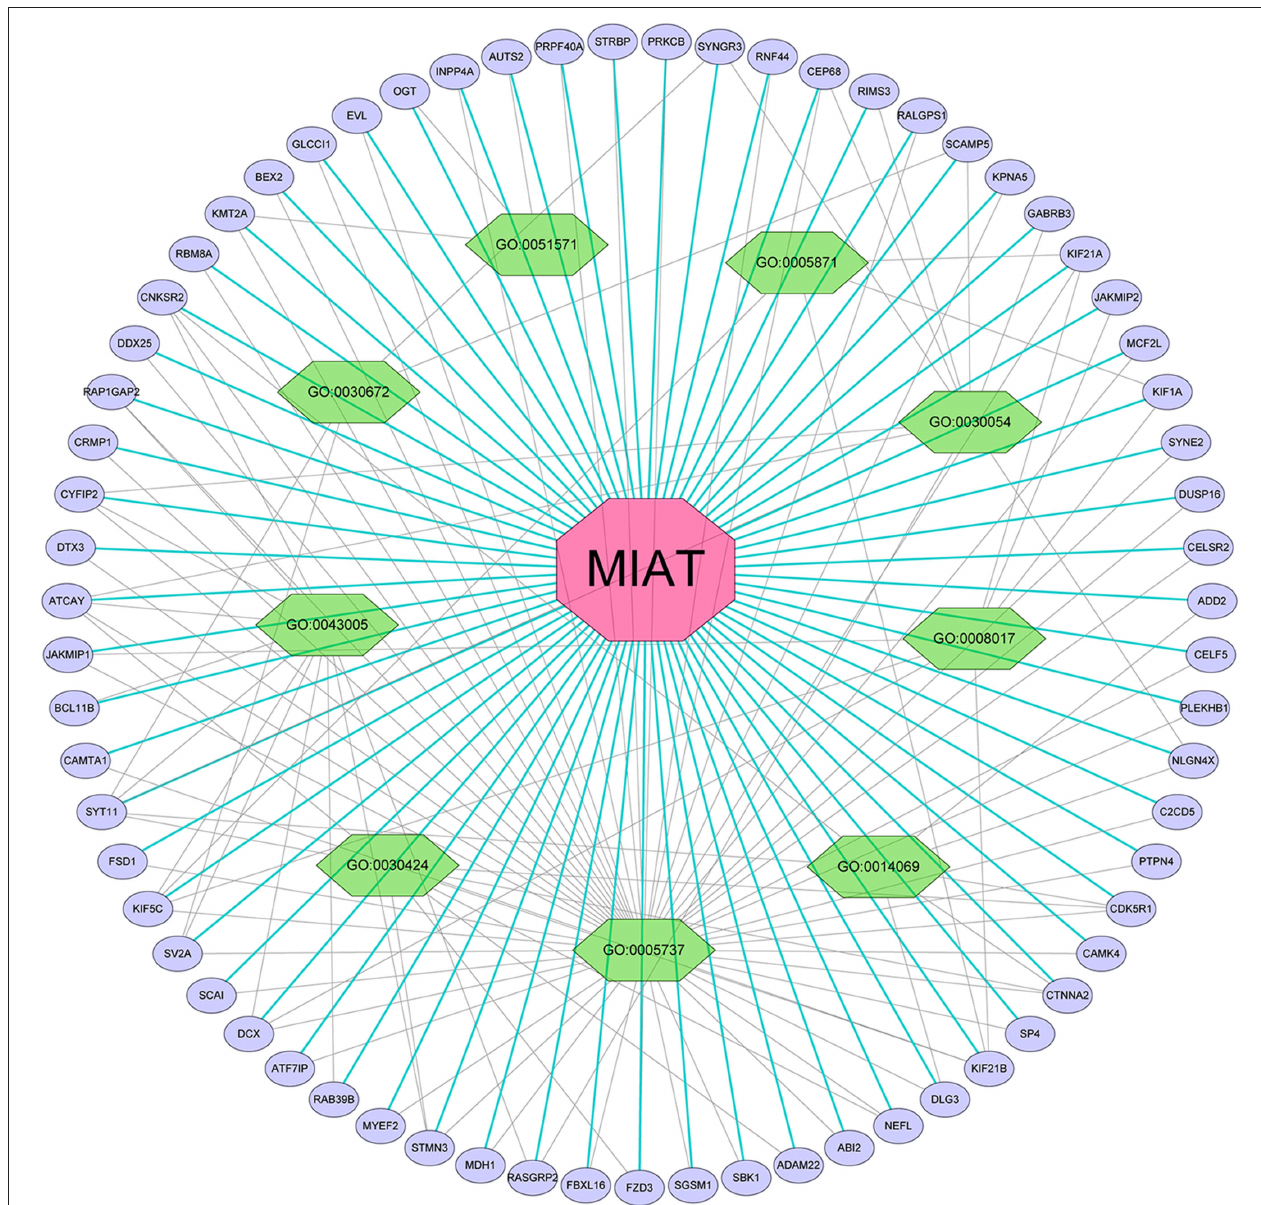
FIGURE 8 | Differentially expressed gene interaction network analysis. Purple nodes represent target genes and green nodes represent the related pathway. As indicated in red, MIAT localized at the center of the